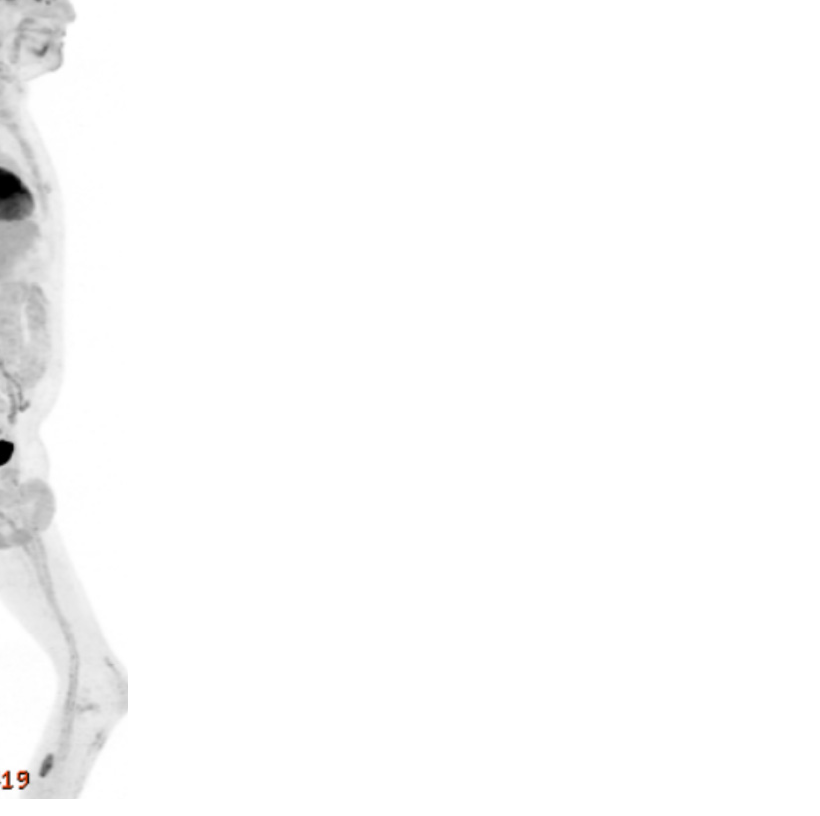
Figure 3. Evidence of relapse on the PET scan performed on December 2019.